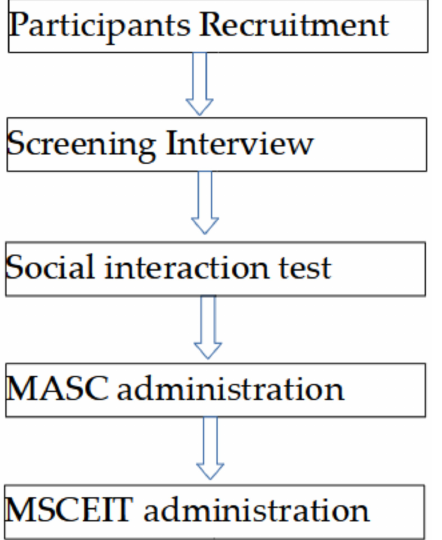
Figure 1. Flow chart of the assessment tools